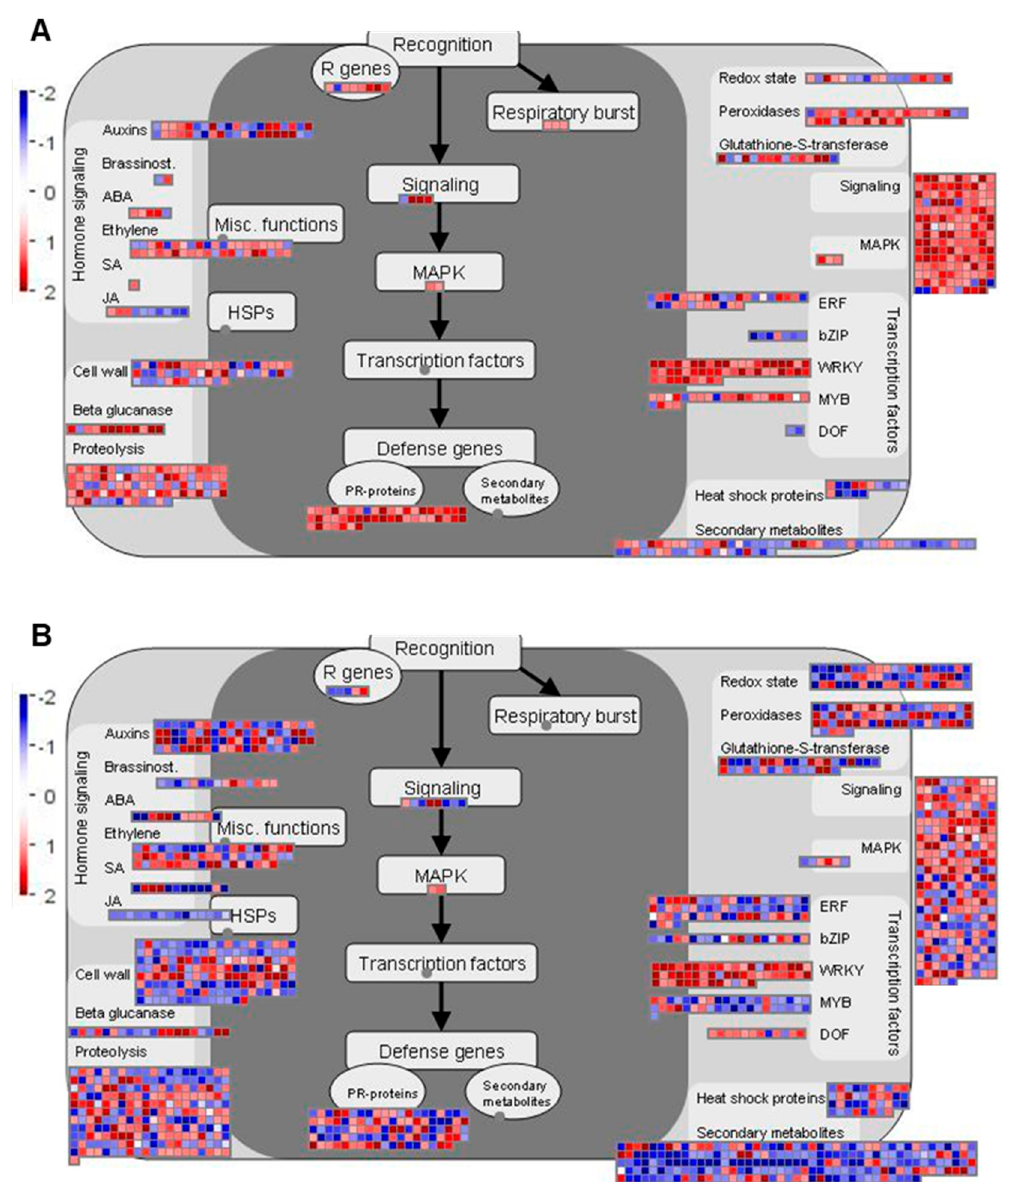
Figure 5. Distribution of differentially expressed genes involved in the biotic stress response in two rutabaga hosts at 14 days after inoculation with Plasmodiophora brassicae . ( A ) ‘Wilhemsburger’ and ( B ) ‘Laurentian.’ The log 2 fold-changes are presented on a scale where red represents upregulation and blue represents downregulation. ABA, abscisic acid; JA, jasmonic acid; SA, salicylic acid; bZIP, basic region-leucine zipper; ERF, APETALA2/Ethylene-responsive element binding protein family; WRKY, WRKY transcription factor; MYB, MYB transcription factor; DOF, DNA-binding one zinc finger transcription factor; MAPK, mitogen-activated protein kinase; PR-protein, pathogenesis-related protein; R genes, resistance genes.